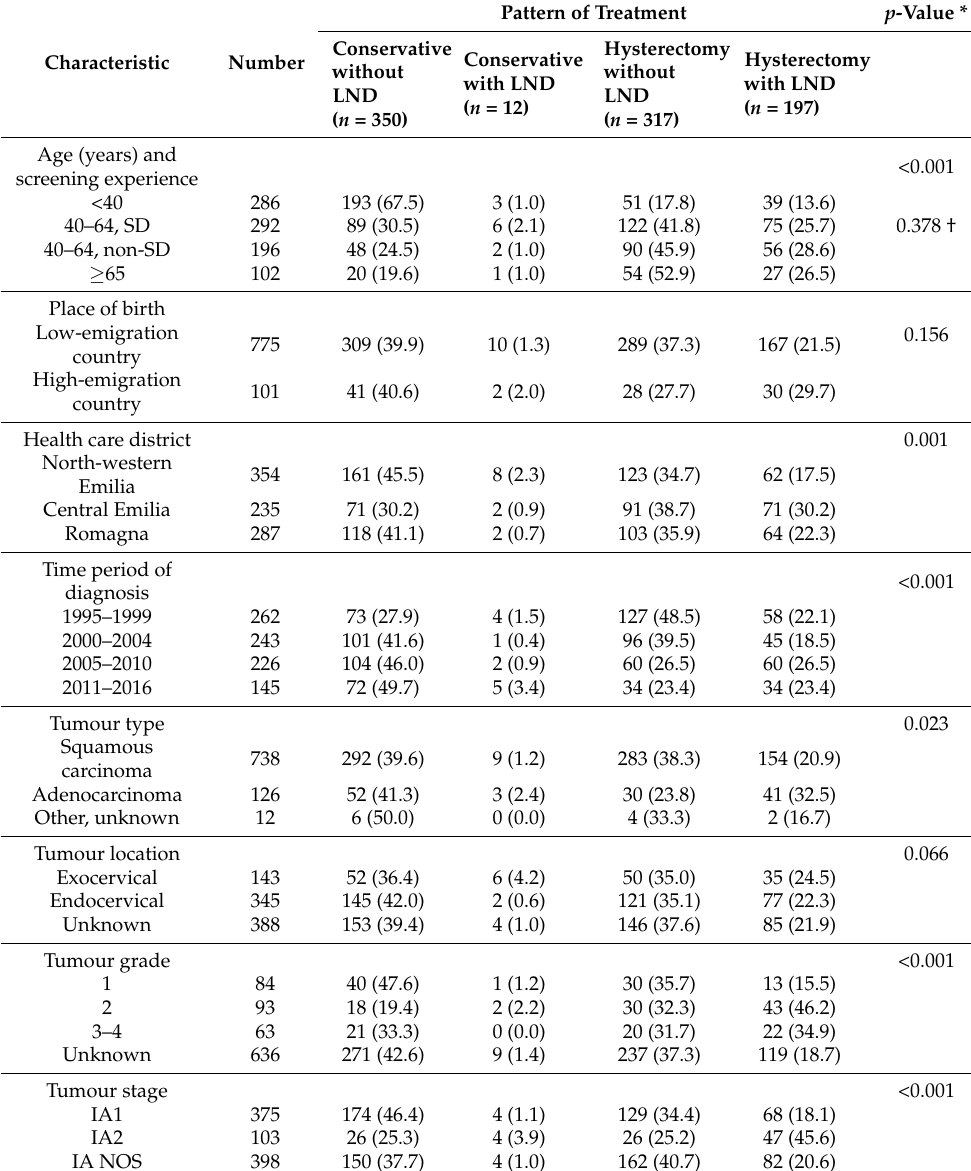
Table 3. Univariate association of registered patient and disease characteristics with the pattern of treatment of stage IA cervical carcinoma. Emilia-Romagna Region, Italy